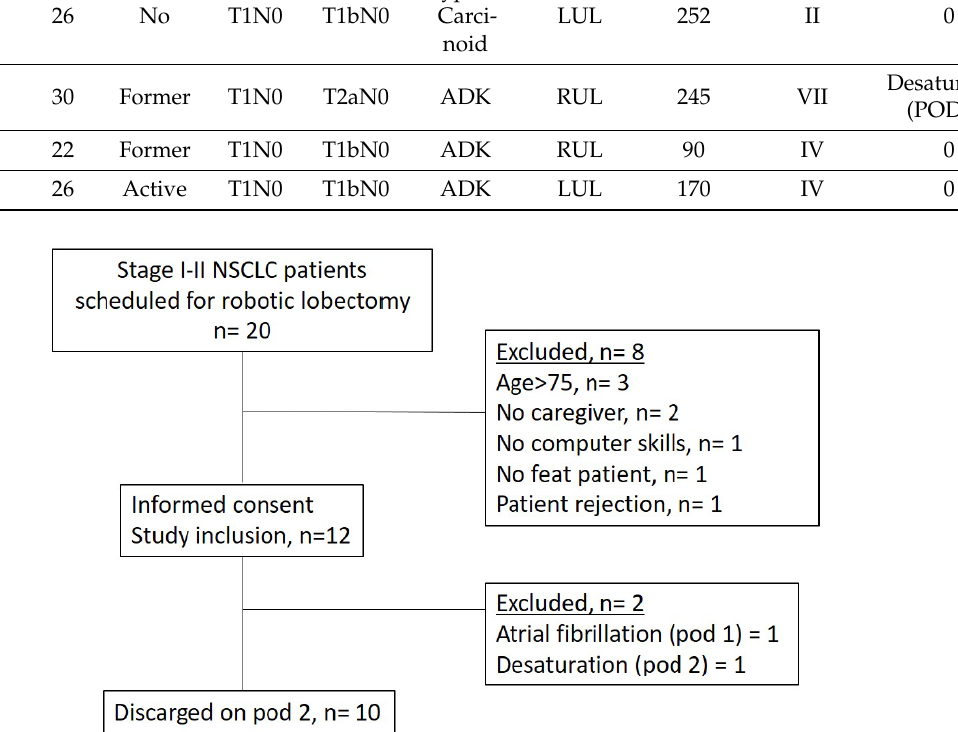
Figure 1. Enrolment and drop out flowchart. Table 1. Patients’ clinical and pathological features .